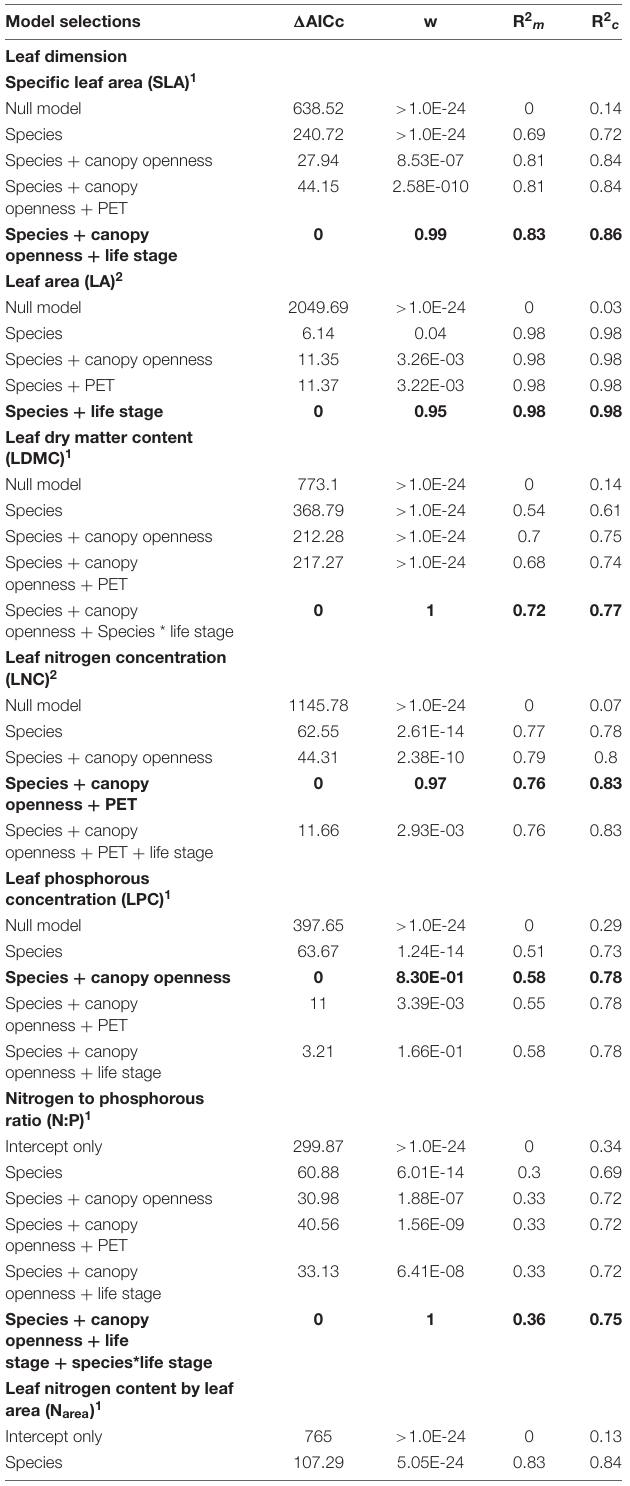
TABLE 2 | Comparison of delta AICc (the difference between AICc values of an alternate model against the best-fit model for a given trait), Akaike weights (w), and marginal R 2 (R 2 m ) and conditional R 2 (R 2 c ) of best-fit trait models from each model selection step, where models with an (cid:49) AICc of 0 are the best-fit model for a given